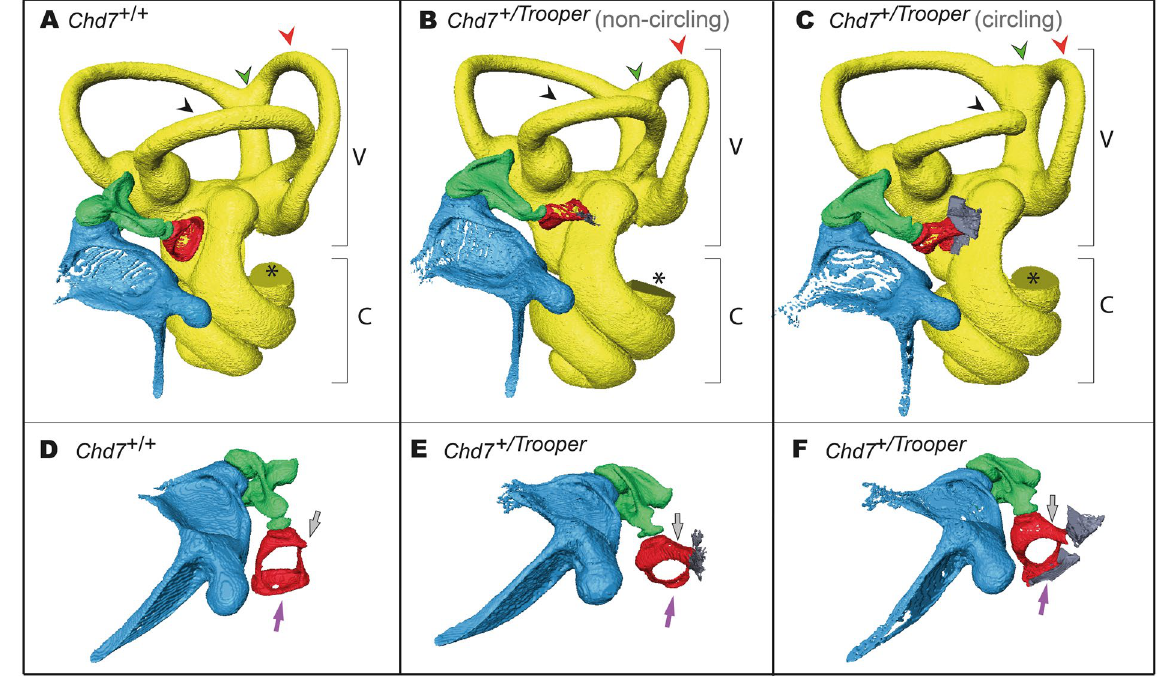
Figure 3. Trooper mice have ossicle and semicircular canal malformations. ( A–C ) X-ray μ CT images of the left middle and inner ears of Chd7 + / + and Chd7 + /Trooper mice including the vestibular apparatus (V) and cochlea (C). The anterior canal (red arrowhead) is hypoplastic and the intersection of the posterior and superior canals (green arrowhead) is enlarged and misshapen in both Chd7 + /Trooper mice when compared with a Chd7 + / + control. ( B ) In the non-circling Chd7 + /Trooper mouse the lateral semicircular canal (black arrowhead) is complete but hypoplastic. ( C ) In the circling Chd7 + /Trooper mouse the lateral semicircular canal (black arrowhead) is incomplete. The missing section in each cochlea ( * ) is an artifact of the imaging/reconstruction process. n = 1 Chd7 + / + and 2 Chd7 + /Trooper mice. ( D,E ) An alternate view of the above middle ears. The Chd7 + /Trooper stapes was rounded and small with an unusual bone growth extending from the tubercle to the otic capsule (grey arrow) and the stapes footplate (purple arrow) was also deformed. In the non-circling Trooper , the footplate was under developed and not contacting the oval window however the more severely affected Chd7 + /Trooper (with circling behavior) has stapedial fusion with the oval